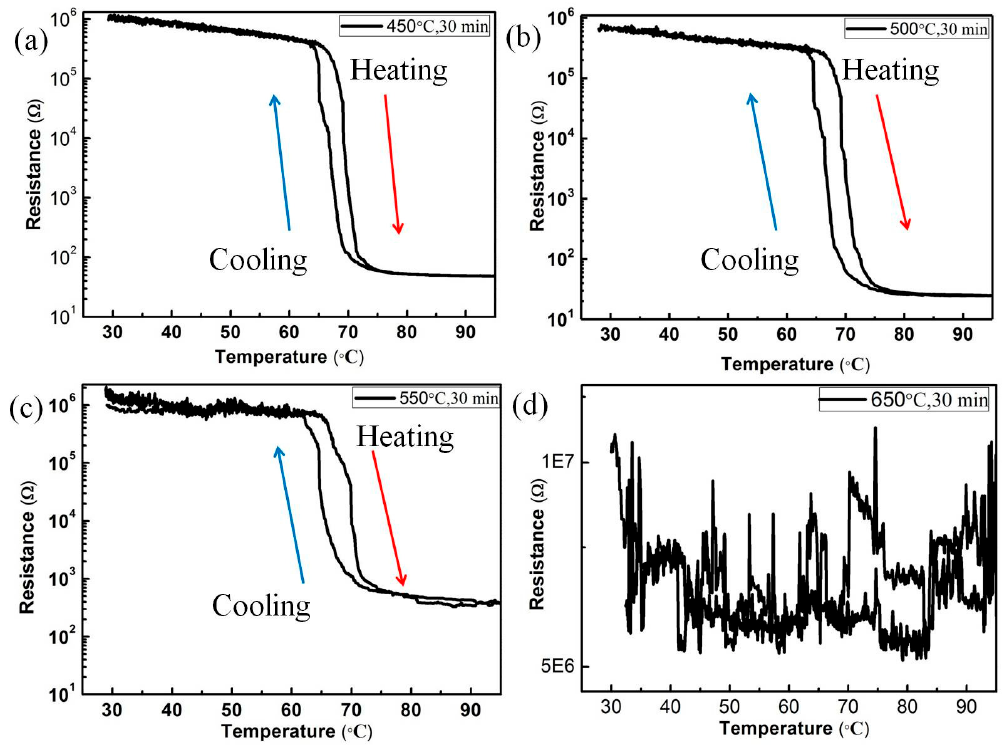
Figure 5. Thermal hysteresis loops of sheet resistance of the samples of S 1 group, ( a )–( d ) corresponding substrate heating temperatures are 450 ◦ C, 500 ◦ C, 550 ◦ C and 650 ◦ C. (a)…; (b)…; (c)…; (d)…